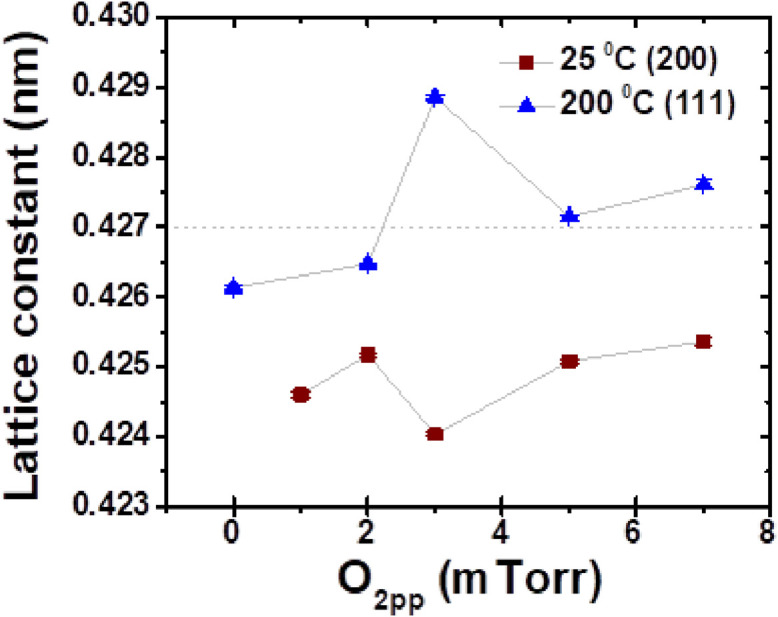
The variation of lattice constant of cuprous oxide films deposited at Tsub ≈ 25 °C (denoted by ■) and Tsub ≈ 200 °C (denoted by ▲) as a function of O2pp. The horizontal dashed line indicates the bulk lattice constant value (a ≈ 0.427 nm) of pure copper oxide.